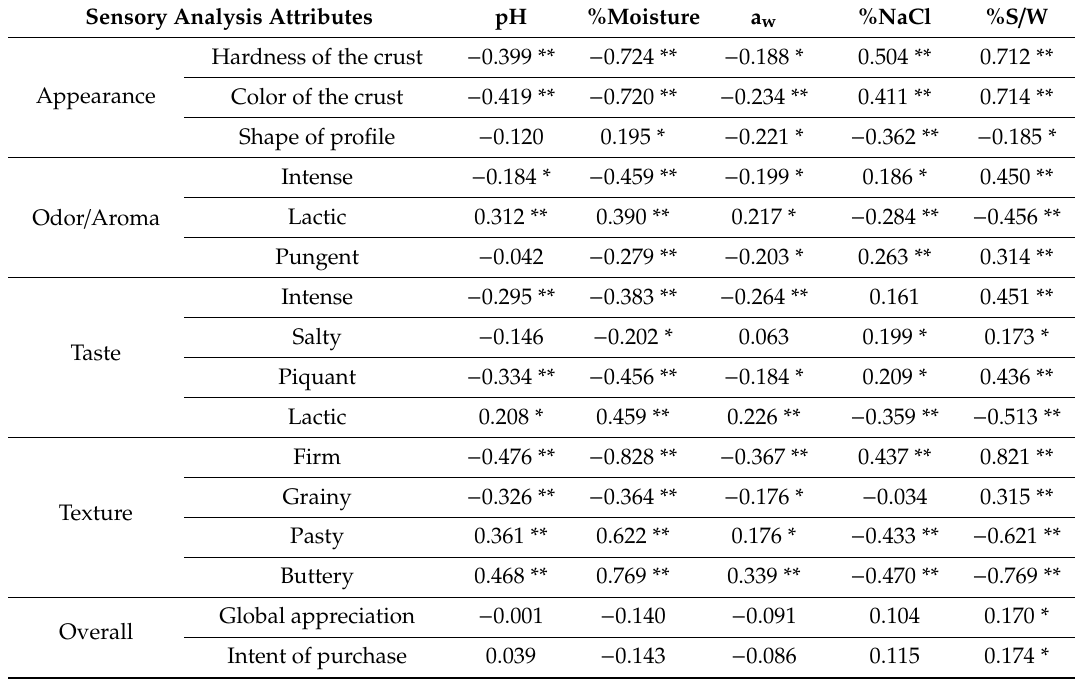
Table 4. Spearman’s correlations between sensory analysis scores and chemical